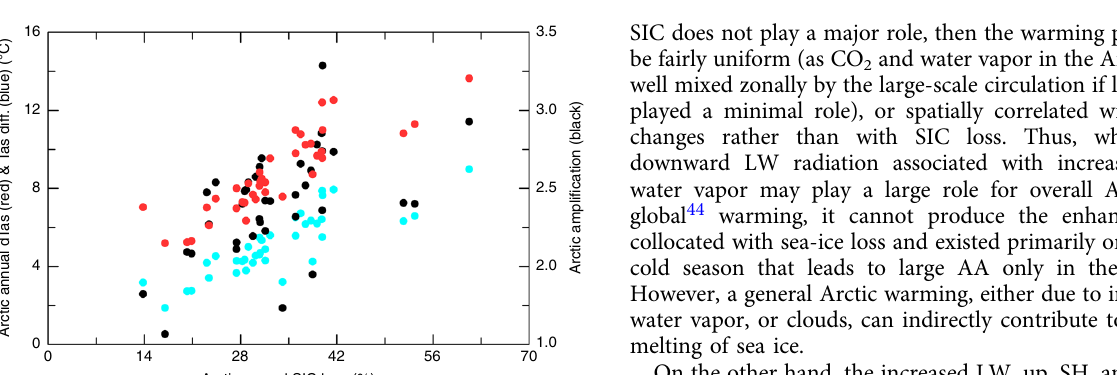
Fig. 3 Centennial changes as a function of month from CMIP5 models. For Arctic (67° − 90°N) sea-ice concerntraion (SIC, in % of Arctic area, shading, multiplied by − 1), Arctic-to-global ratio of the Tas change (AA, black line, multiplied by 10 in order to use the left y-axis), and Arctic surface energy fl uxes (in W m − 2 ). a 2070 – 2099 minus 1970 – 1999, b 2170 – 2199 minus 2070 – 2099, and c 2270 – 2299 minus 2170 – 2199 under the historical and RCP85 scenarios from the ensemble mean of nine model runs from the nine CMIP5 models. Net SW = net shortwave radiation (positive downard), upward LW = upward longwave radiation, SH = sensible heat, LH = latent heat. d Time-dependent warming and sea-ice loss from CMIP5 models. Time series of the difference between the 20 year periods separated by the plotted year in annual Arctic (67° − 90°N, red solid) and global-mean (red dashed) surface air temperature (Tas), annual Arctic SIC (blue), and the difference between the red solid and red dashed lines (black) based on the ensemble mean of nine simulations from nine CMIP5 models. The correlation coef fi cient between the lines are: r (SIC, Tas_Arctic) = − 0.97, r (sic,Tas_global) = − 0.90, r (sic, Tas_diff) = − 0.95, and r (sic, AA) = − 0.80, where AA = the ratio of the Arctic to global Tas change (data before 2000 were not used for AA). These correlations have a p -value well below 0.01